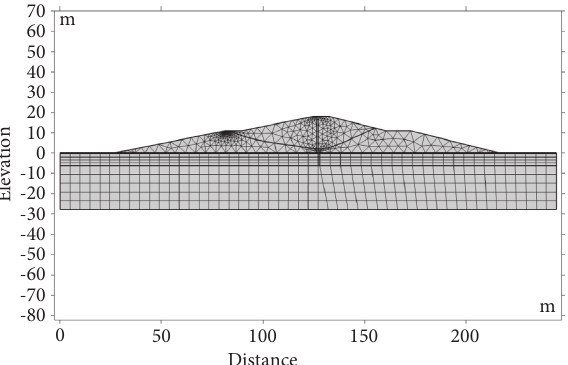
Figure 3: Fluid-solid coupling numerical analysis model.